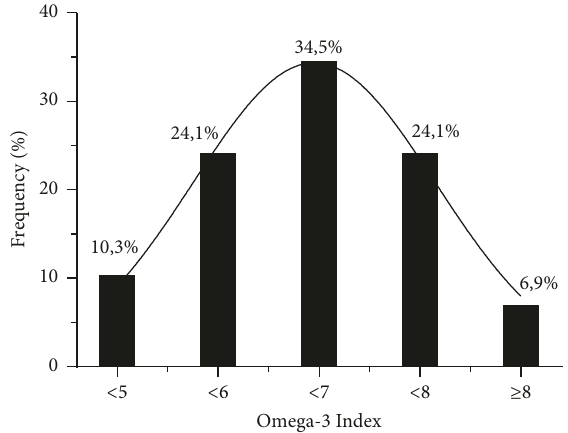
Figure2:DistributionofthebasalOmega-3Indexinthepopulation of athletes of this